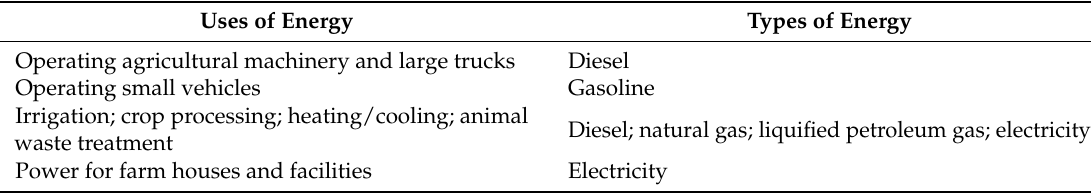
Table 1. Direct energy uses in agricultural